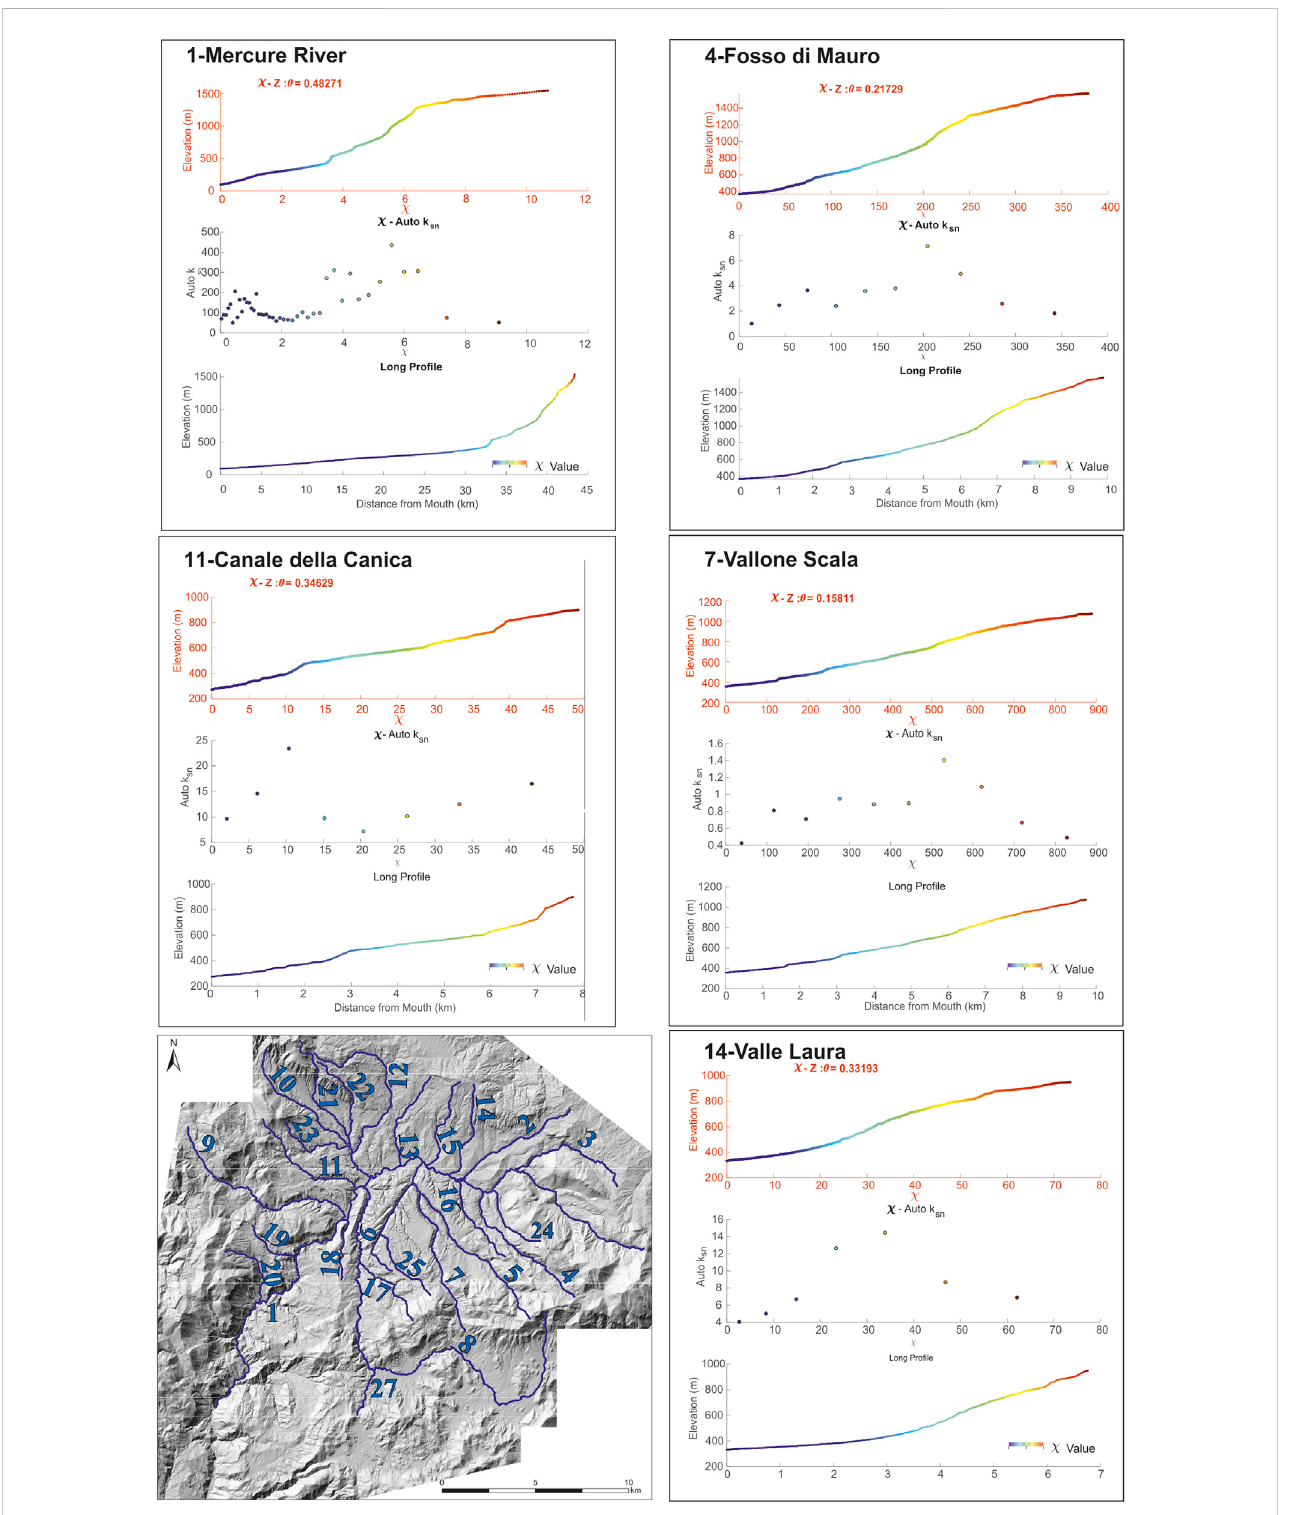
FIGURE 7 Examplesofrepresentativelongitudinalpro fi lesoftheMercureRiverbasin.Numberinginthemapshowsthetributariesmodelledbyriverpro fi